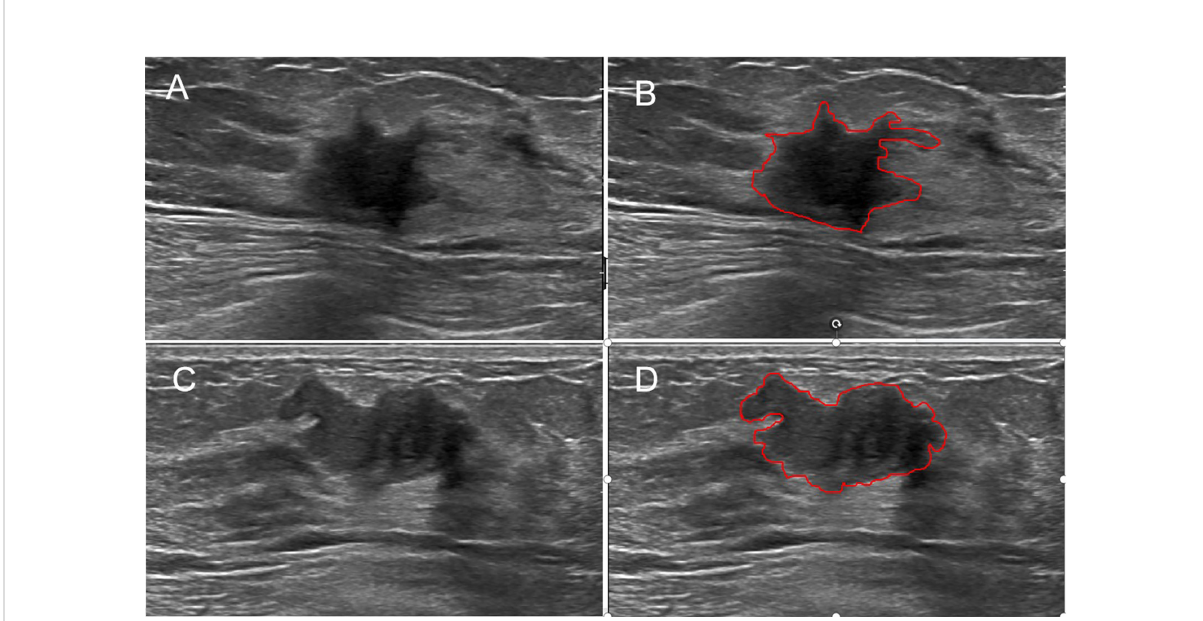
FIGURE 2 Examples of sketching ROIs on US images. The greyscale image (A) and the ROI (B) of a malignant lesion with the maximum section (radiomics score= − 14.95). The greyscale image (C) and the ROI (D) of a benign lesion with the maximum section (radiomics score= −